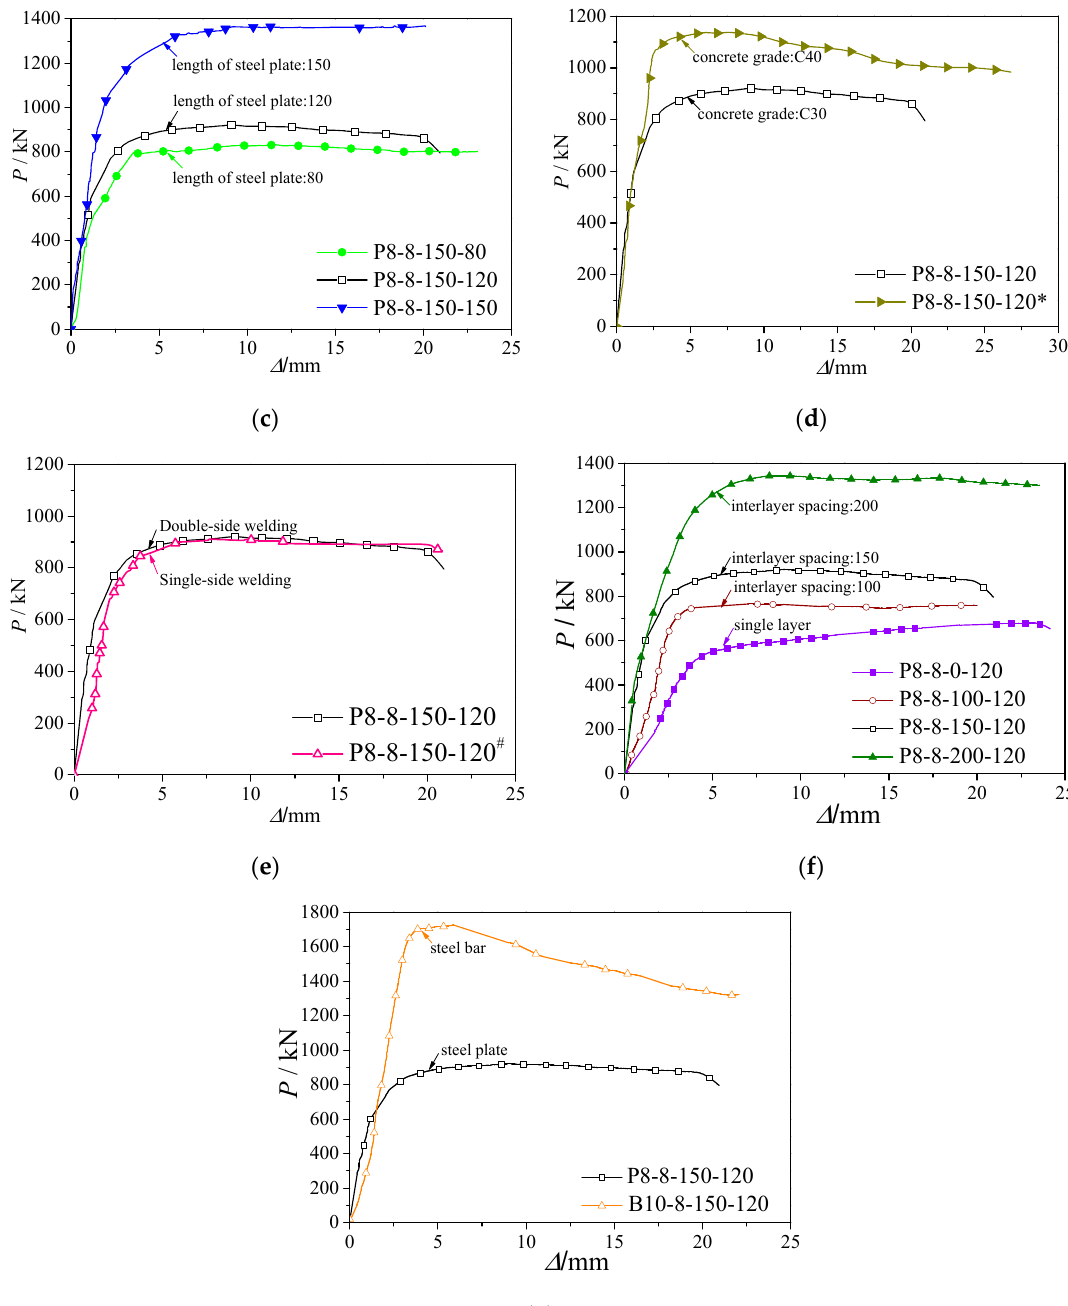
Figure 7. The load-displacement curves. ( a ) Effect of width to thickness ratio of steel tube; ( b ) Effect of thickness of steel plate; ( c ) Effect of length of steel plate; ( d ) Effect of concrete strength; ( e ) Effect of welding condition; ( f ) Effect of interlayer spacing; ( g ) Effect of type of shear connectors.